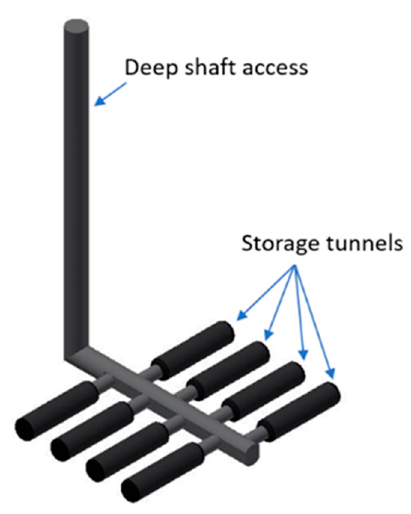
Figure 11. Layouts of storage tunnels using deep shafts.